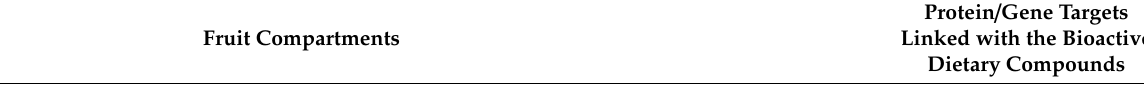
Table 3. Dietary phytoconstituents detected in the fruit compartments of Musa species and the analytical